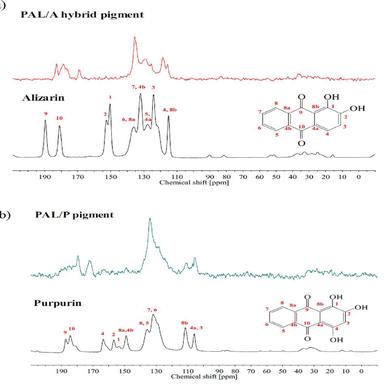
13C solid state NMR spectra for alizarin (a), purpurin (b), and corresponding hybrid pigments made from palygorskite.